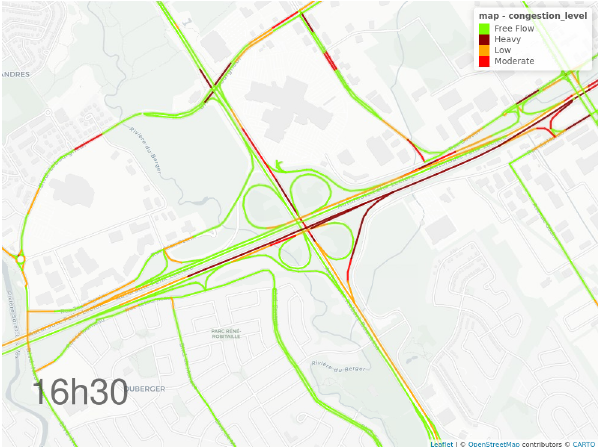
Figure 10. Traffic map with model M at 16:30 p.m. over the junction of Aut. Félix-Leclerc and Aut. Robert-Bourassa, Quebec